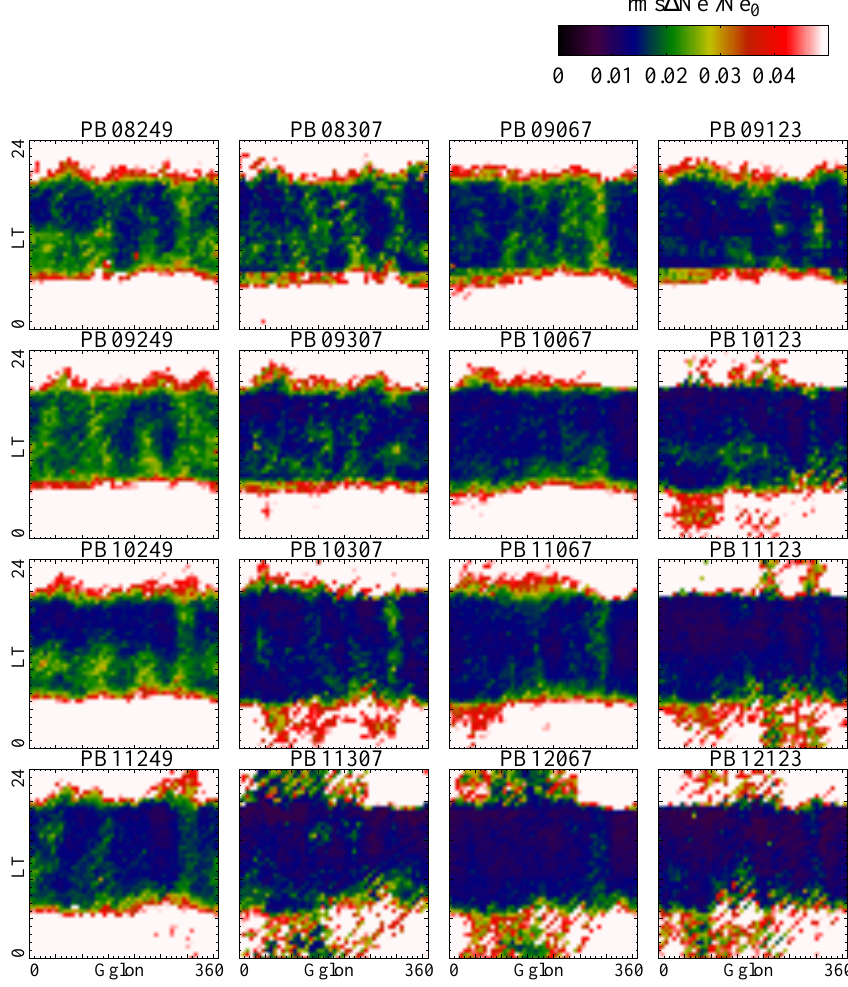
Fig. 7. Climatology of the ratio of rms density irregularity to ambient plasma density as a function of longitude and local time (LT), integrated over altitudes and averaged over seasons from (Northern Hemisphere) summer 2008 (upper left) to spring equinox 2012 (lower right). The scale of this dimensionless quantity (0 to 0.05) was chosen to show the daytime